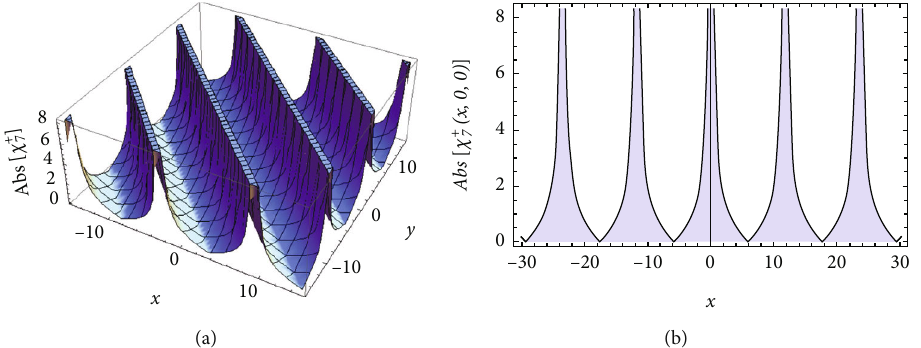
x , y , t Þj with the parameters λ = 1 , v = 1 , v 5 ð